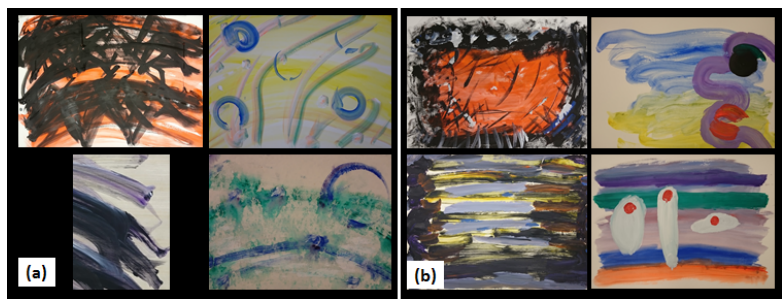
Figure 6. Examples of ( a ) abstract paintings by our robot, compared with ( b ) paintings by an artist. In each, the top left painting represents the angry quadrant, the top right represents the joyful quadrant, the lower right represents the relaxed quadrant, and the lower left represents the sad